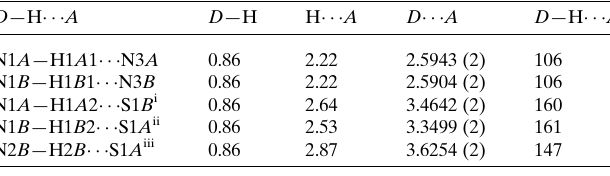
Table 1 Hydrogen-bond geometry (A˚ , (cid:5) ).